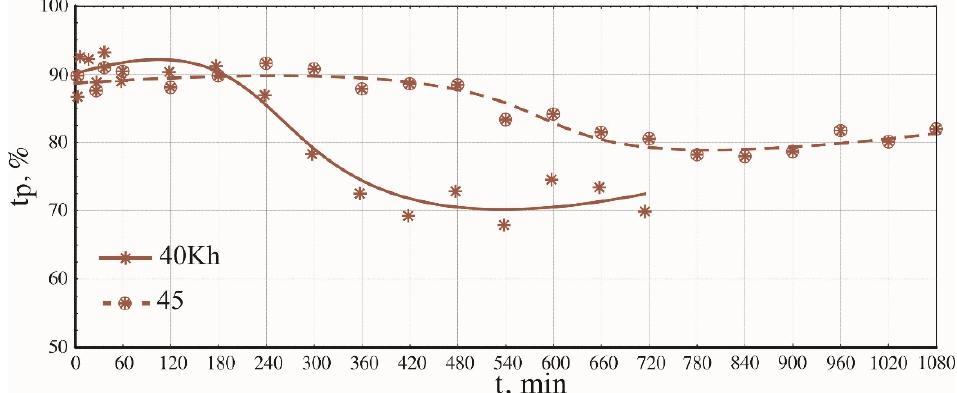
Figure 9. Dynamics of changes in the roughness parameter tp.